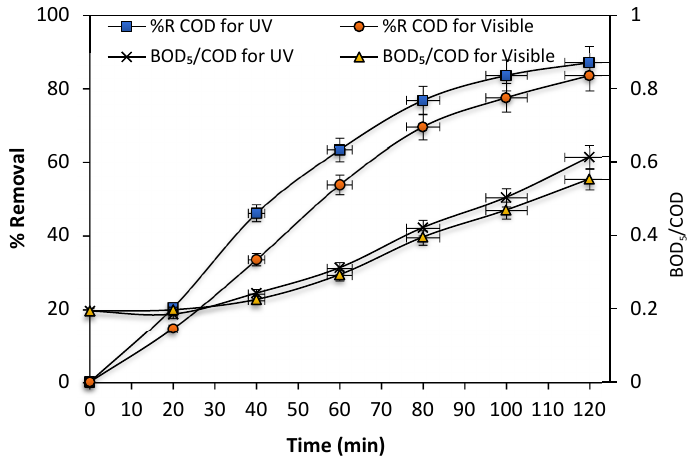
Figure 6. Elimination of COD in real textile wastewater and degradability of the final effluent.